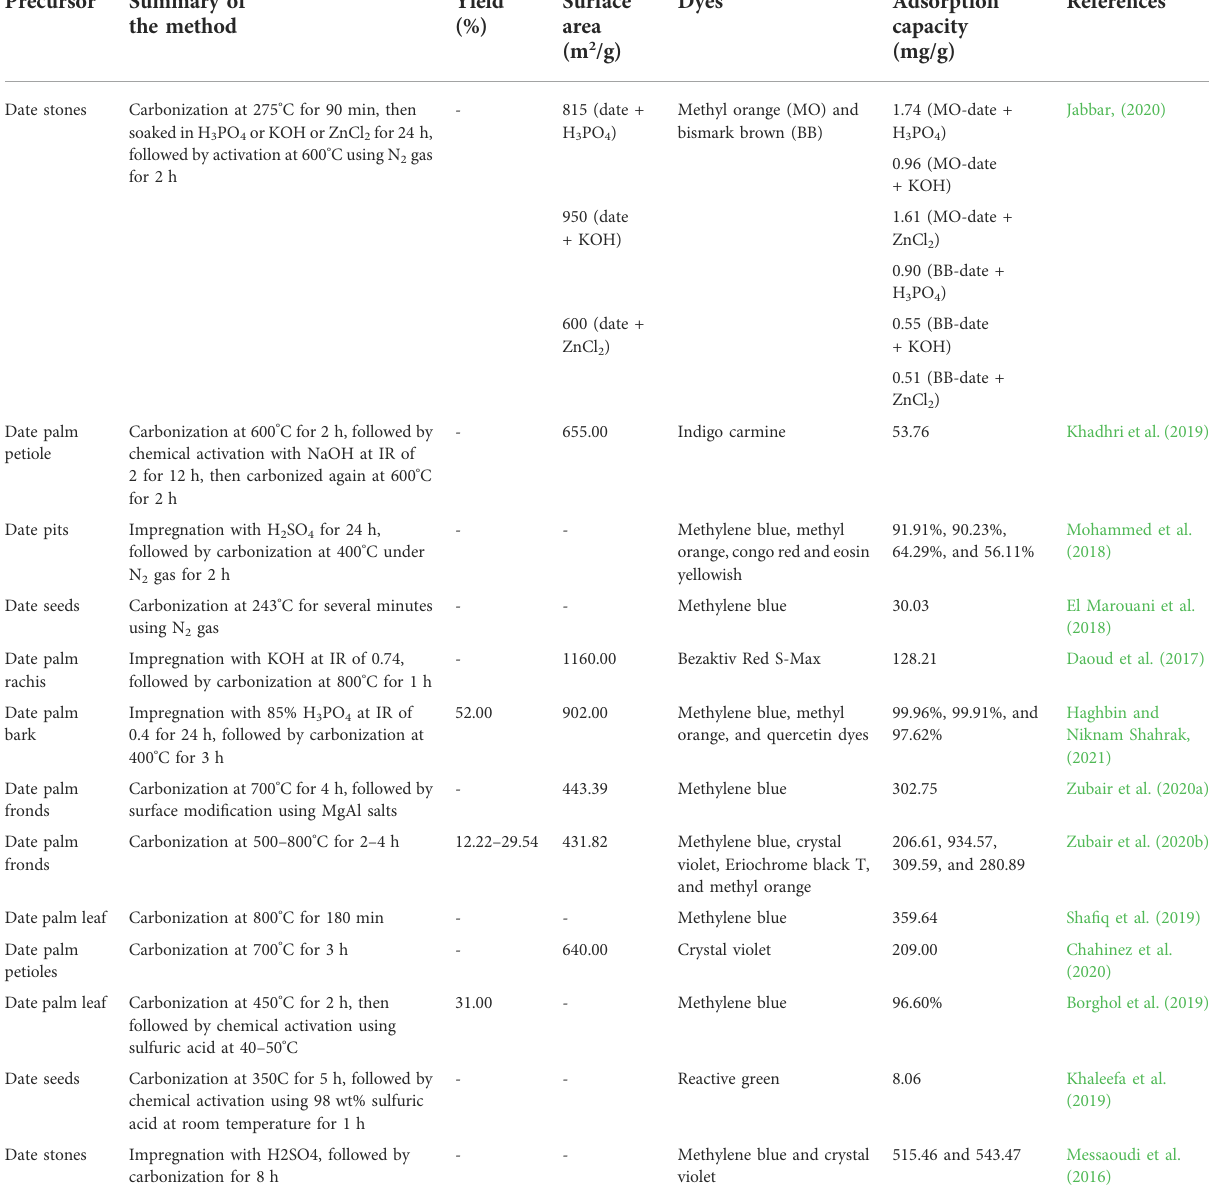
TABLE 2 Summary of the literatures on converting date palm residues into activated carbon via conventional